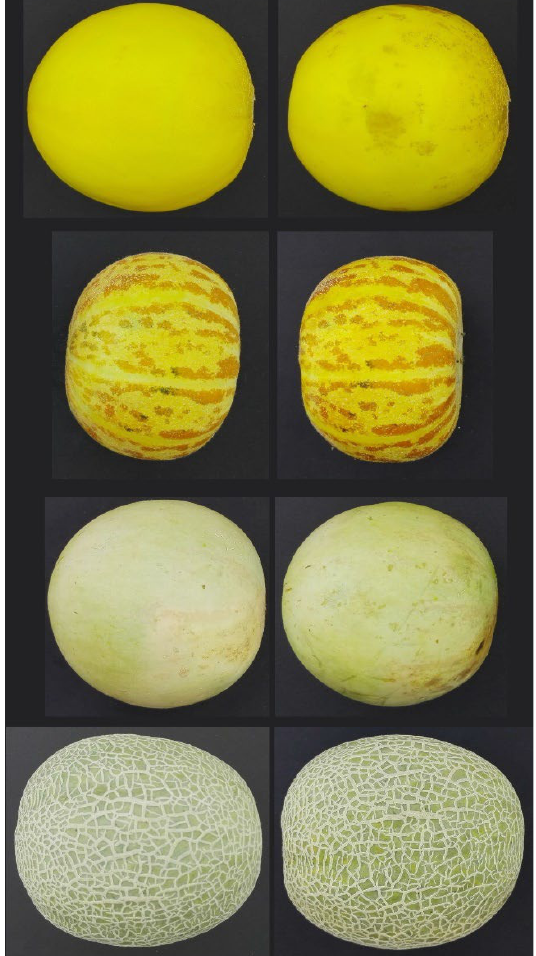
Figure 4. Sample images for different genotypes of melon. Each raw represents a genotype. The left column is the sample at harvest, while the right column represents the same sample after one month of cold storage at 4